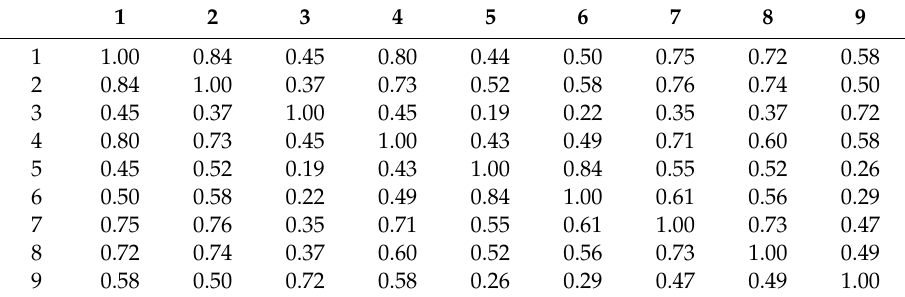
Table 8. Fuzzy similarity matrix.